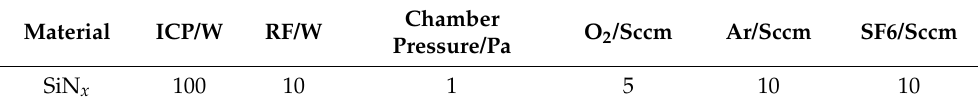
Table 1. SiN x etching process parameters.